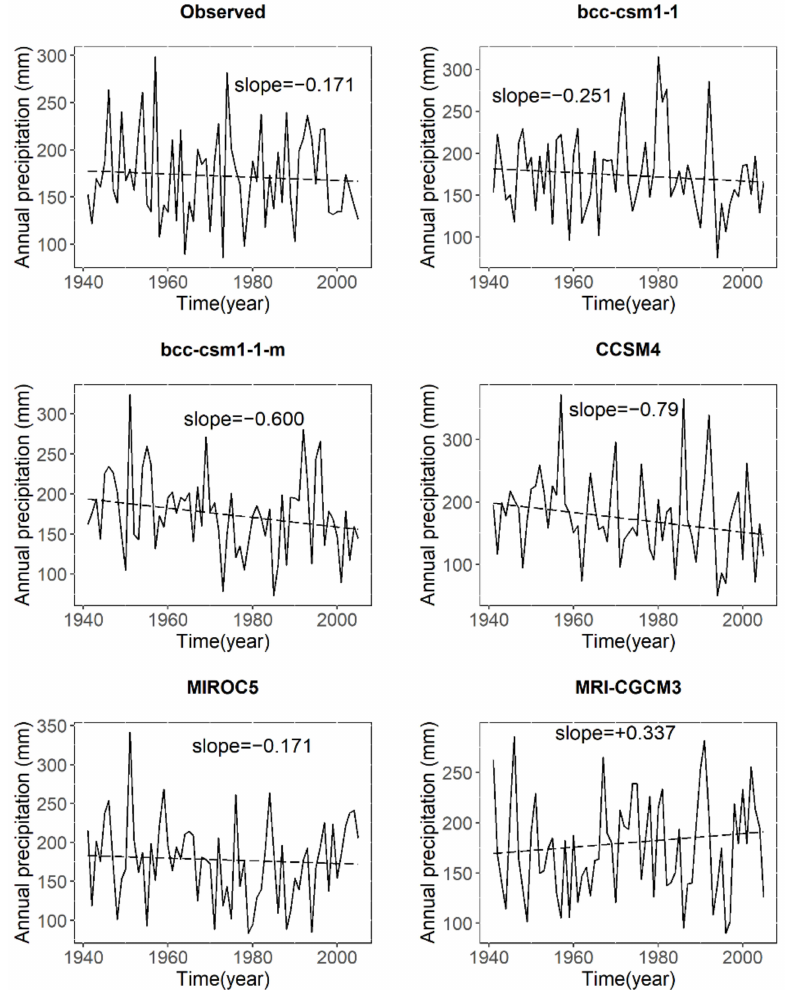
Figure 14. Linear trends of areal average annual rainfall for the observed and simulated time series using the Mann–Kendall trend